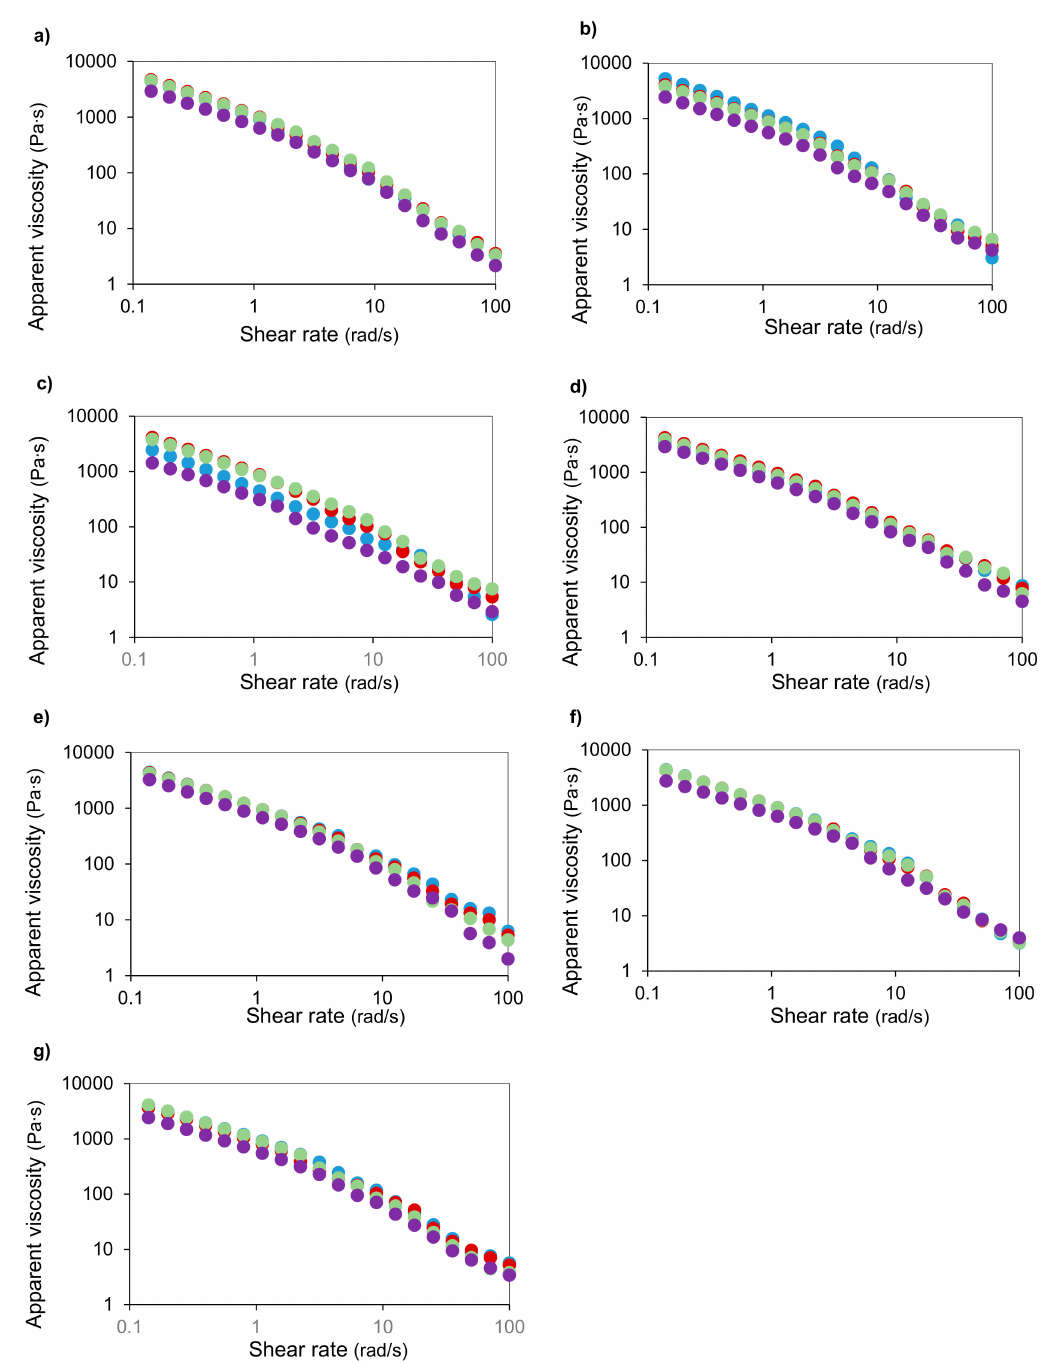
Figure 6. Viscous behavior of the sun cream formulated with selected MHG extracts from ( a ) C. scoparius flowers, ( b ) P. ostreatus mushrooms, ( c ) B. rapa leaves and ( d ) Q. robur acorns and ( e ) BHT, ( f ) ( ± )- α -tocopherol and ( g ) water control. Color code: distilled water (blue), thermal spring water 1 (red), thermal spring water 2 (green) and thermal spring water 3